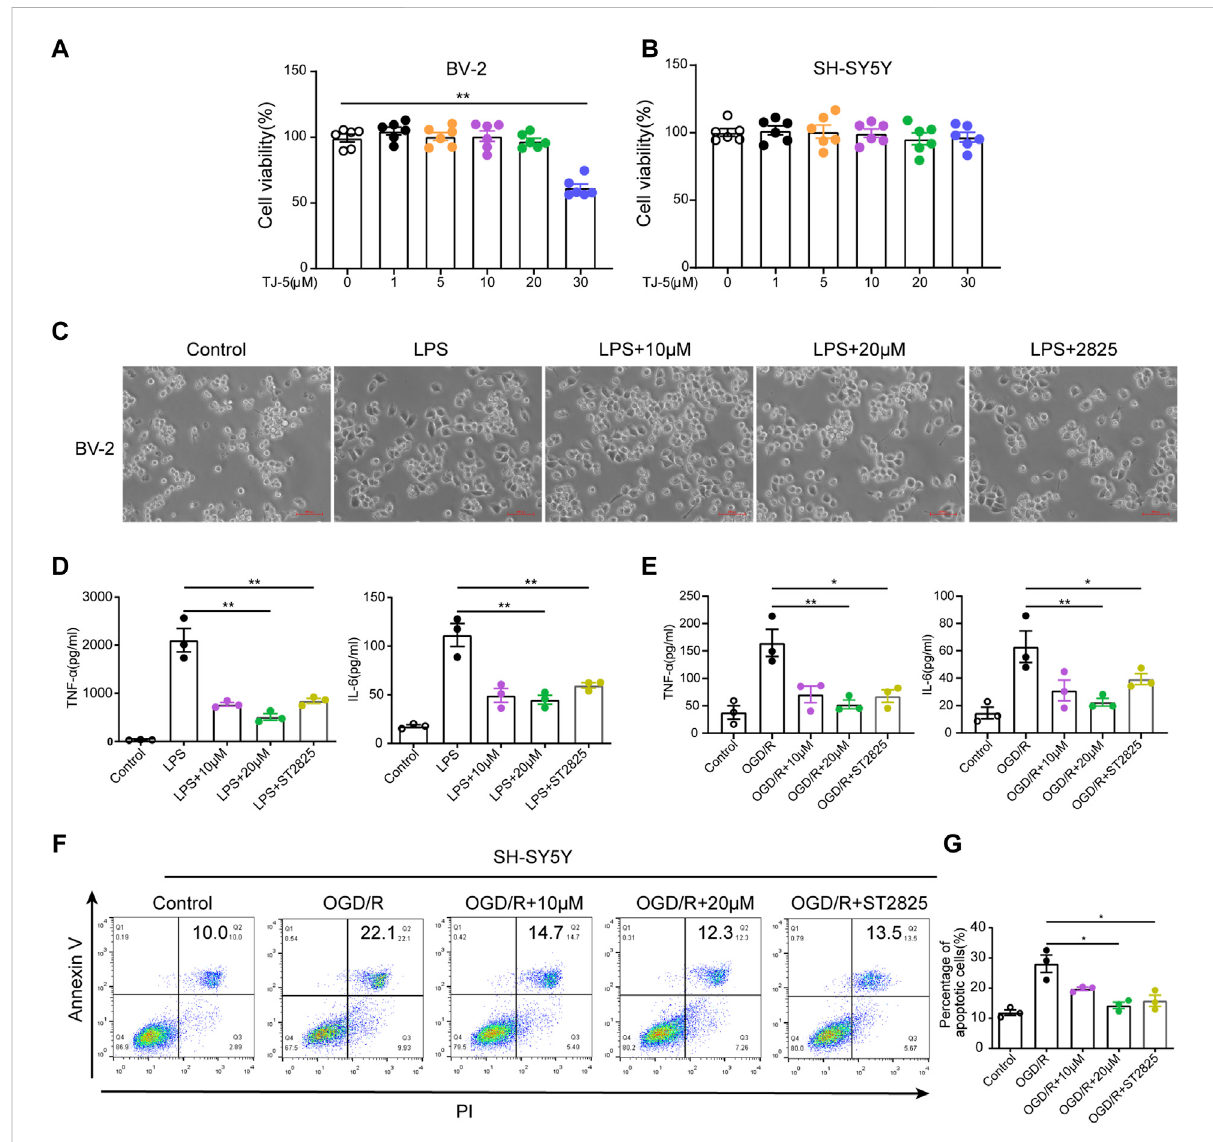
FIGURE 6 Effect of TJ-5 intervention on LPS or OGD/R-stimulated BV-2 cells and OGD/R-induced SH-SY5Y cells. BV-2 cells were pretreated with TJ-5 for2 hbeforeLPSorOGD/Rstimulationfor24 h.SH-SY5YcellswereexposedtoOGDfor4 handthentreatedwithTJ-5duringreperfusionfor24 h MyD88 inhibitor ST2825 was used as positive drug. (A) Cell viability of BV-2 cells at 24 h after TJ-5 intervention. (B) Cell viability of SH-SY5Y cells at 24 h after TJ-5 intervention. (C) The morphology of BV-2 cells was observed under the microscope. TJ-5 inhibited the activation of